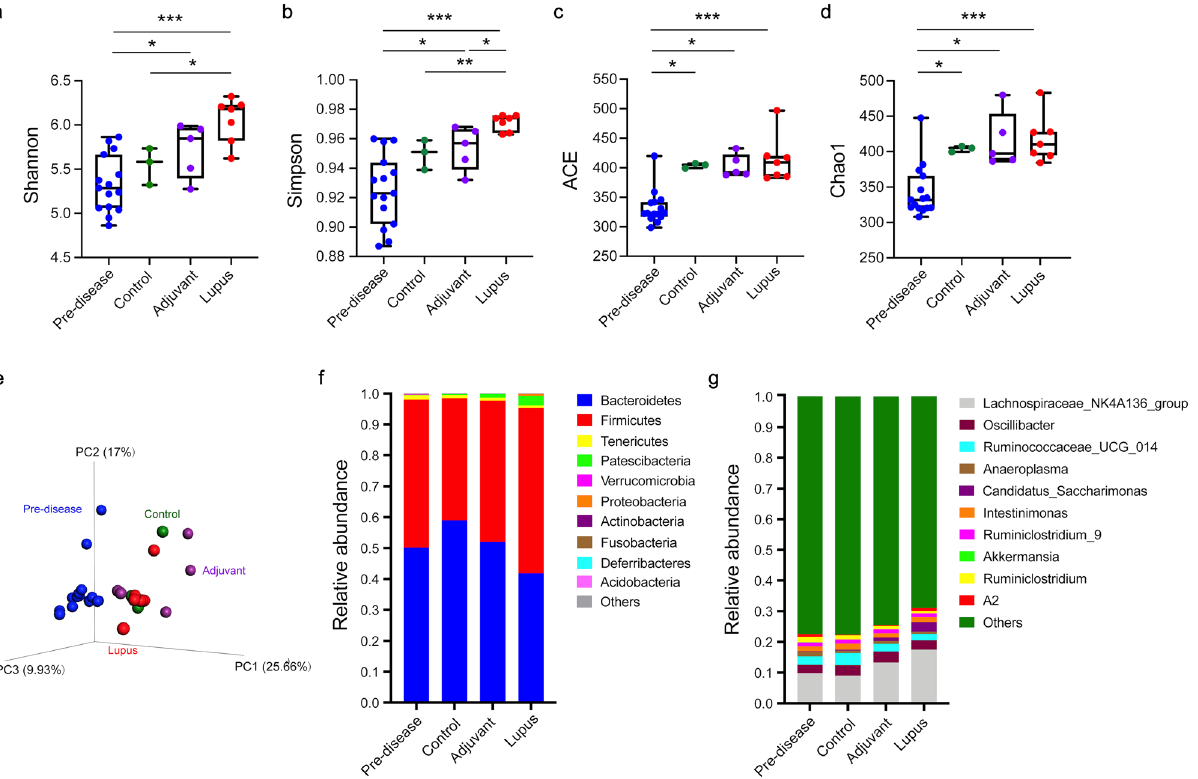
Figure 2. Microbial community structure. ( a ) Shannon, ( b ) Simpson, ( c ) ACE, and ( d ) Chao1 alpha diversity indices analyzed by the Kruskal–Wallis test. Statistical analysis was performed using ANOVA and Student’s t -test. The beta diversity of ( e ) principal coordinate analysis (PCoA) was evaluated by unweighted UniFrac and Bray–Curtis distances. Relative distributions of the top 10 ( f ) phyla and ( f ) genera. Data are means ± SEM. * P < 0.05, ** P < 0.01, and *** P < 17A were higher in HCMVpp65 422-439 -immunized mice at 12 weeks post-immunization (24 weeks of age, lupus group) compared with NZB/W F1 mice treated with PBS (control group) or adjuvant only (adjuvant group, Fig. 1b–e). Anti-dsDNA antibody, serum creatinine, and proteinuria levels were elevated in the lupus group at 12 weeks post-immunization (24 weeks of age, Fig. 1f–h). Moreover, the lupus group had larger spleens, more severe renal damage, and a higher glomerulonephritis score compared with the other two groups (Fig. 1i–k). These findings suggest that HCMVpp65 422-439 immunization induced lupus-like effects. Microbial composition in NZB/W F1 mice. To investigate the microbial community in NZB/W F1 mice, we analyzed fecal samples collected before immunization (predisease, 12 weeks of age) and at disease time points (lupus, adjuvant, and control groups, 24 weeks of age) by 16S rRNA gene sequencing. The alpha and beta diversities were measured to evaluate alterations in microbial composition. As shown in Fig. 2a, b, the lupus group had significantly higher Shannon’s ( P = 0.033) and Simpson’s ( P = 0.008) diversity index values (extent of microbial diversity), but there was no difference in the ACE or Chao1 index values (extent of microbial rich- ness), compared with the control group. A higher Simpson’s index value was found in the lupus group than in the adjuvant group. Microbial diversity and richness did not differ significantly between the adjuvant and con- trol groups (Fig. 2a–d). For beta diversity analysis, the pattern variations in the microbial community structure among the lupus, adjuvant, and control groups are listed in Table 1. The three-dimensional principal coordinate analysis (PCoA) plot showed distinctions in community composition among the four groups (Fig. 2e). PC1, PC2, and PC3 showed 9.93%, 17%, and 25.66% of the total variance in microbial species, respectively (Fig. e). PCoA of the Bray–Curtis distance matrix revealed differences in microbial community composition among the lupus, adjuvant, and control groups (Supplementary Fig. 2). Figure 2f, g shows the relative abundances of the top 10 bacterial phyla and genera. At the phylum level, Bacteroidetes (59.0%) was the most abundant in the control group, followed by Firmicutes (39.5%), Tenericutes (1.0%), and Patescibacteria (0.3%) (Fig. 2f). The lupus group, compared with the adjuvant group, had increased abundances of Firmicutes (53.5% vs . 45.7%), Patescibacteria (3.1% vs . 1.7%), and Proteobacteria (0.6% vs . 0.007%) and decreased abundances of Bacteroidetes (41.8% vs . 52%) and Tenericutes (0.7% vs . 0.9%). At the genus level, the genera (top 10) in the relative abundance of Lach- nospiraceae NK4A136 group ( f_ Lachnospiraceae ), Oscillibacter ( f_Oscillospiraceae ) , Ruminococcaceae UCG 014 ( f_ Ruminococcaceae ) , Intestinimonas, Candidatus Saccharimonas ( f_ Saccharimonadaceae ) , Ruminiclostridium , Ruminiclostridium 9 ( f_ Ruminococcaceae ), and Anaeroplasma ( f_Anaeroplasmataceae ) were observed in the